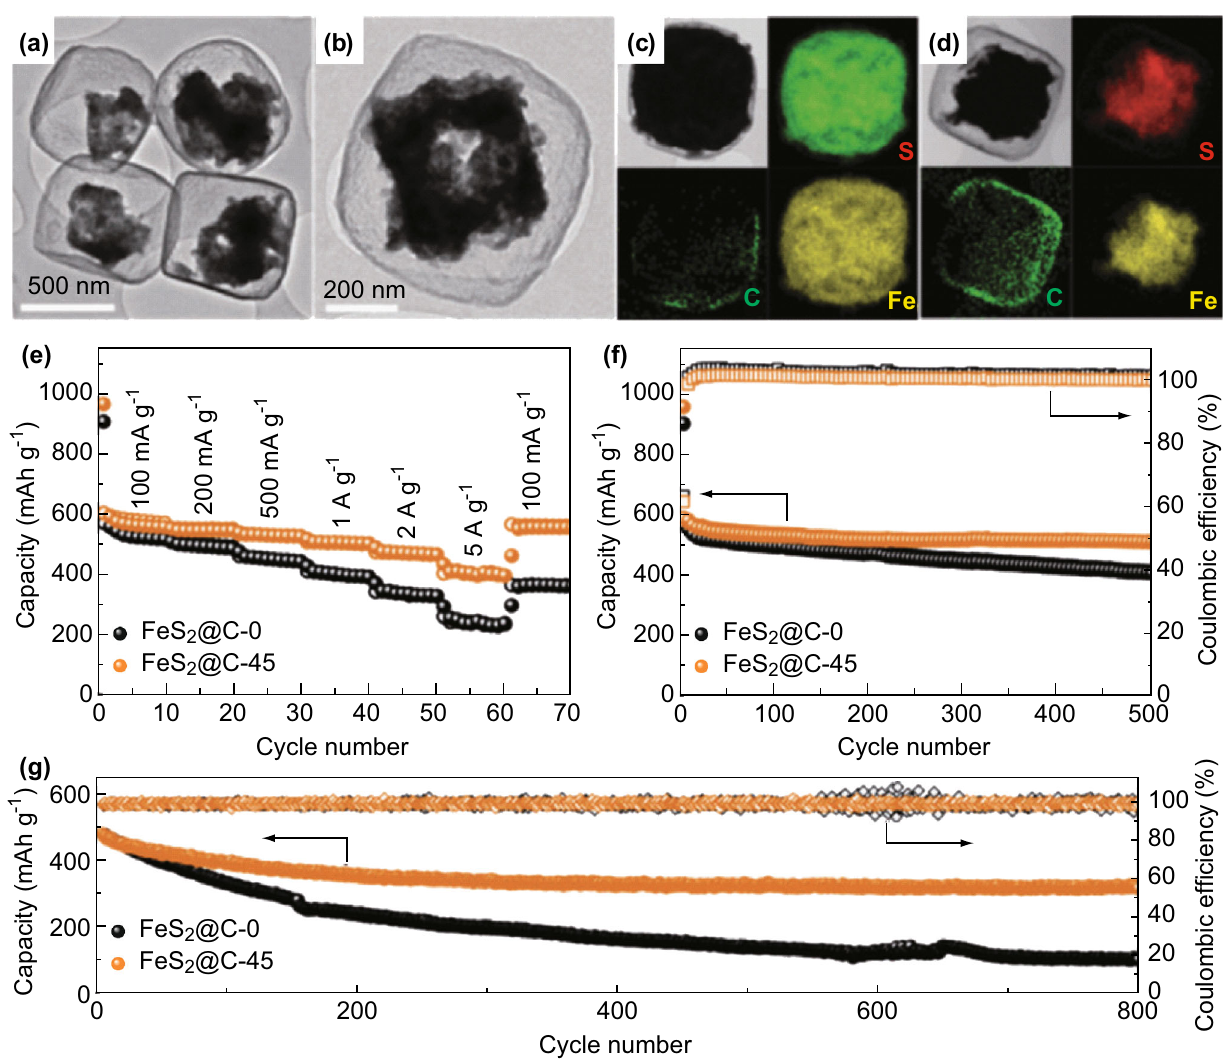
Fig. 6 a TEM image and b HRTEM image of FeS 2 @C with 45-minute etching. Element mapping images of: c FeS 2 @C-0 and d FeS 2 @C-45. e Comparison of rate performance of